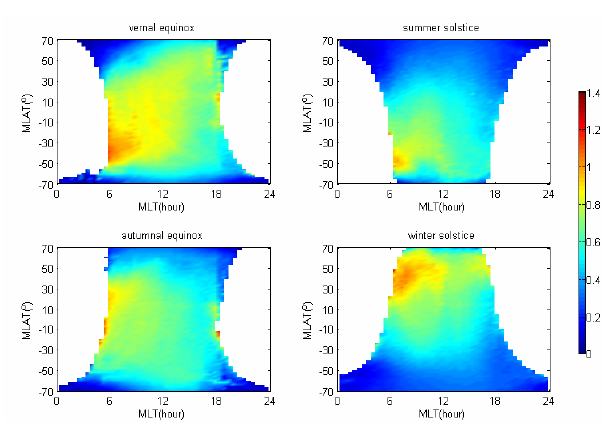
Figure 4. Distribution of the columnar [O/N2] centered at equinox and Fig. 4. Distribution of the columnar [O/N2] centered at equinox and solstice during the year 2003. solstice during the year